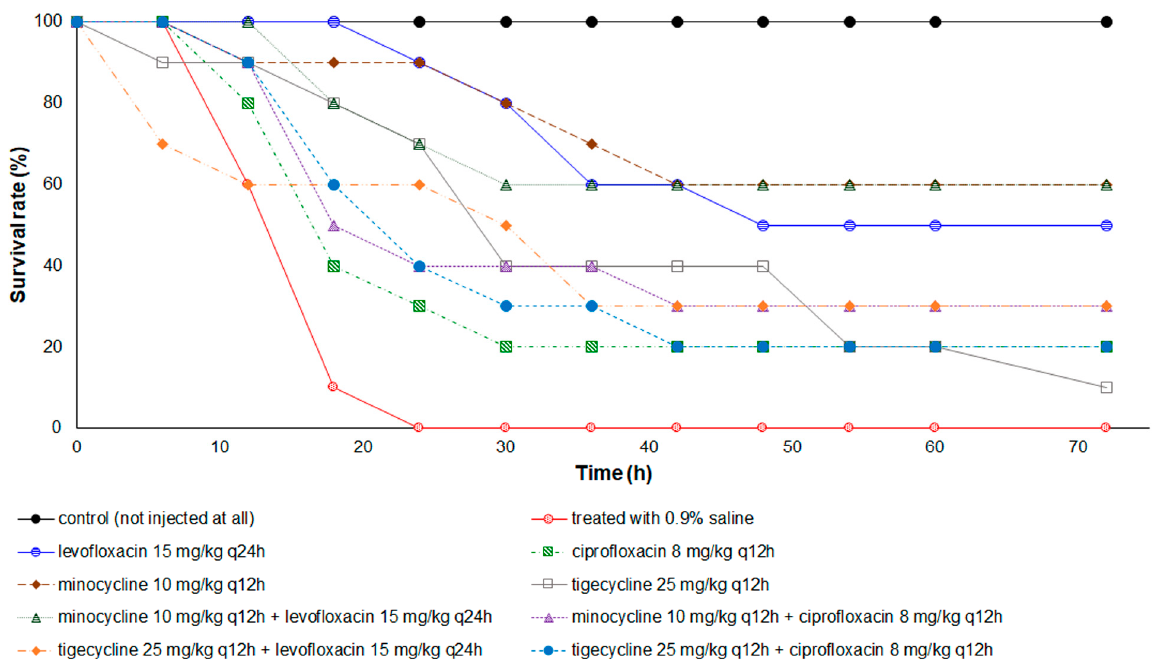
Figure 6. Kaplan–Meier survival curves of the 72-h cumulative survival rate for zebrafish infected with E. anophelis strain ED853-49. All zebrafish treated with 0.9% saline died within 24 h. Zebrafish treated with antibiotic(s) exhibited a significantly higher survival rate than those treated with 0.9% saline ( p < 0.005). The log rank test: Minocycline versus tigecycline, p = 0.035; levofloxacin + minocycline versus tigecycline, p = 0.049; and others, no significant difference.